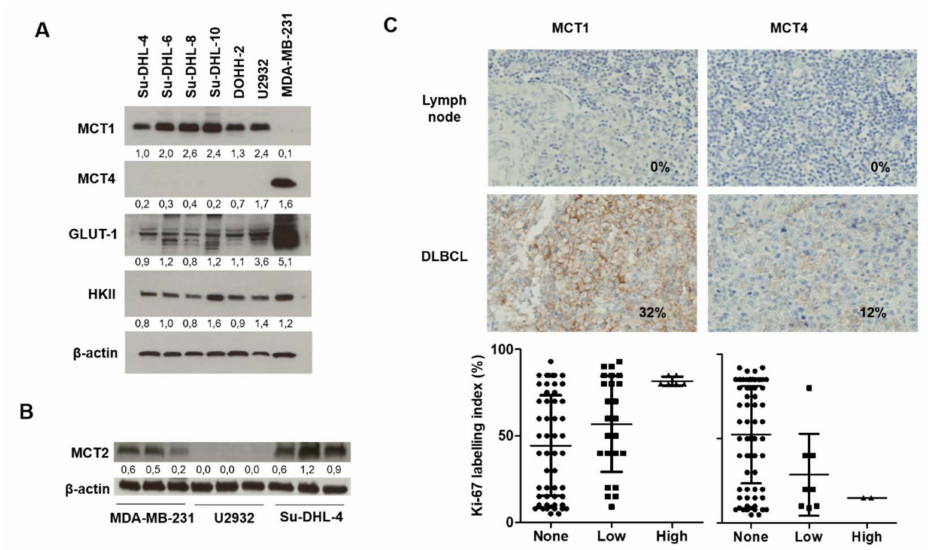
Figure 1. The monocarboxylate transporter MCT1 is expressed in di ff use large B cell lymphoma cell lines. ( A ) Expression of monocarboxylate transporters MCT1 and MCT4, glucose transporter GLUT-1 and hexokinase II in six di ff use large B cell lymphoma cell lines and the MDA-MB-231 cell line that is known to be deficient in MCT1 expression. ( B ) Expression of monocarboxylate transporter MCT2 in MDA-MB-231, U2932 and Su-DHL-4 cell lines. Values represent the ratio of protein to β -actin, which was used as a loading control; uncropped blots from ( A ) and ( B ) are shown in Figure S2. ( C ) Typical immunostains of MCT1 and MCT4 in uninvolved lymph nodes and stage I / II DLBCL (images above) and the relationship between MCT1 / 4 expression and Ki67 in stage I / II DLBCL (graphs